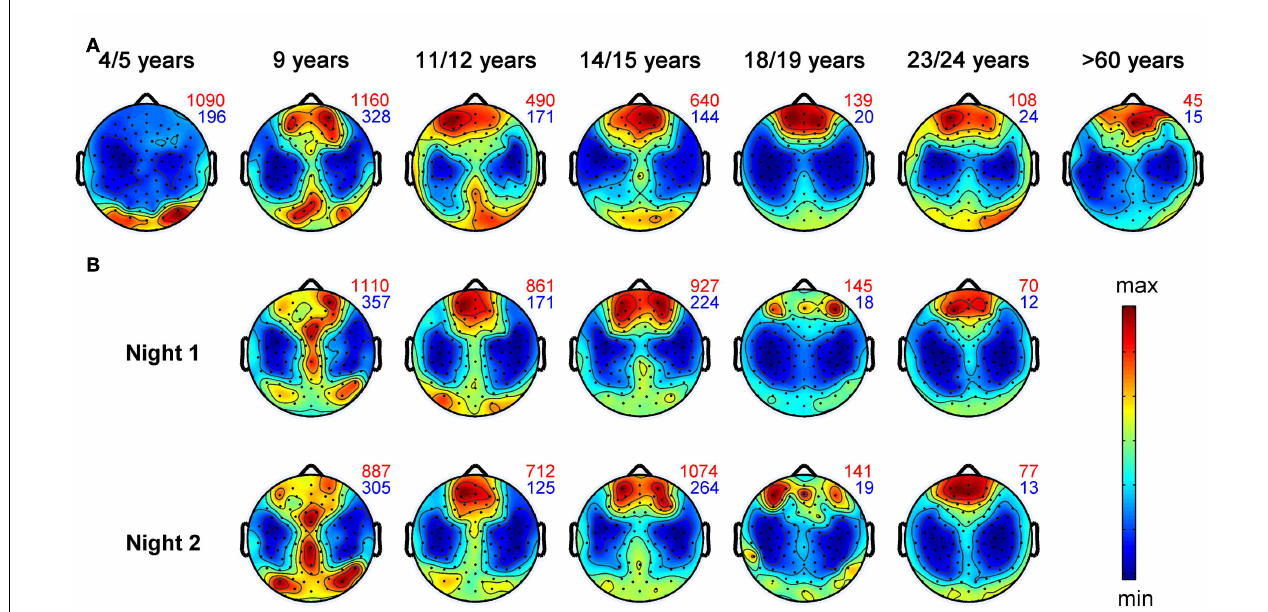
selected from the study by Kurth et al. (2010).Topographical plots of healthy control subjects older than 60years from Neumann et al. (unpublished data) (A) Maturation of slow wave topography illustrated for 4- to > 60-year-old subjects. Each plot includes data of one representative subject. (B) Each column represents the SWA maps of two different sleep sessions (at least 1week apart) for one subject.The two maps of each subject illustrate the topographical “fingerprint” of the power distribution in the SWA range.